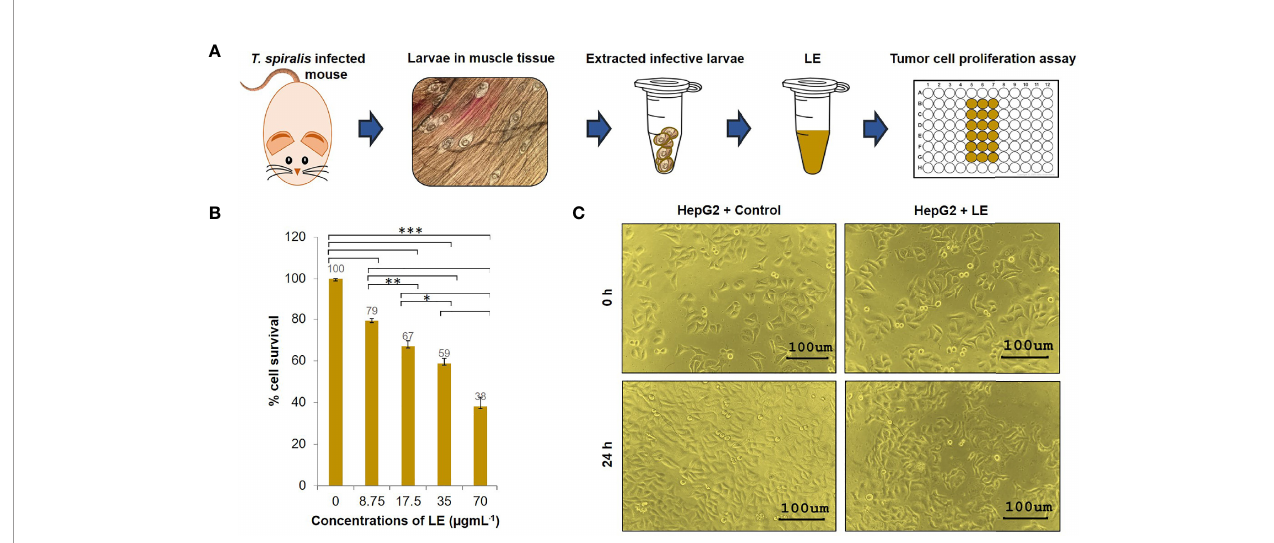
FIGURE 2 | Cytotoxic effects of the infective larval extract (LE) of T. spiralis on human hepatocellular carcinoma HepG2 cells. (A) Preparation of the LE from T. spiralis infective larvae collected from infected mice. (B) Percentage cell survivals of HepG2 cells at 24 h posttreatment with different concentrations (8.75, 17.5, 35, and 70 µgmL -1 ) of LE. The results are shown as the mean ± standard deviation (SD) of three independent experiments. ∗ P < 0.05; ∗∗ P < 0.01; ∗∗∗ P < 0.001. (C) Proliferations and morphological changes in HepG2 cells treated with LE (70 µgmL -1 ) compared with untreated cells at 24 h. The cells were visualized microscopically at 200× magni fi cation.